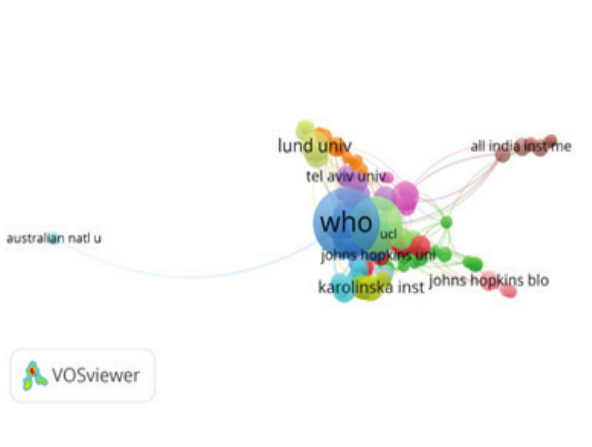
Figure-IV: Co-authorship countries network visualization